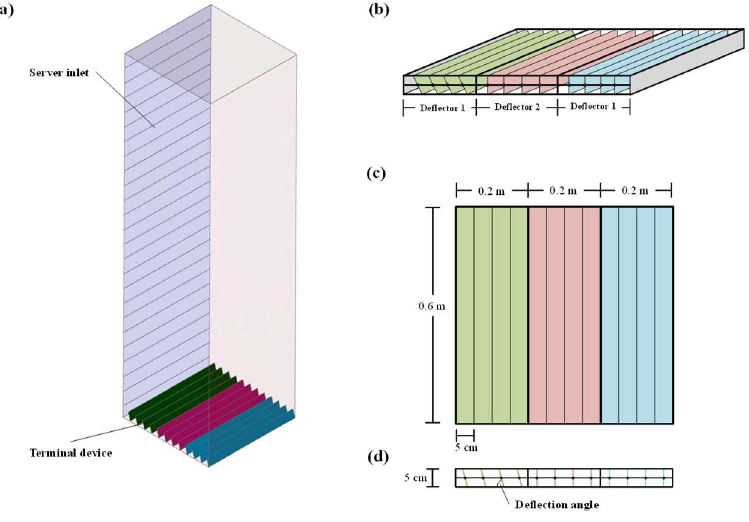
Figure 1. Schematic diagram of terminal device.